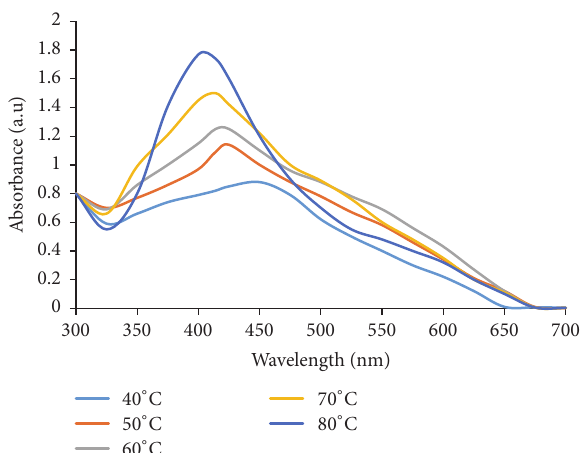
Figure 2: UV-Vis absorption spectra of WMRE-AgNPs sample SF 31 showing the effect of variation of temperature on WMRE-AgNPs synthesis.